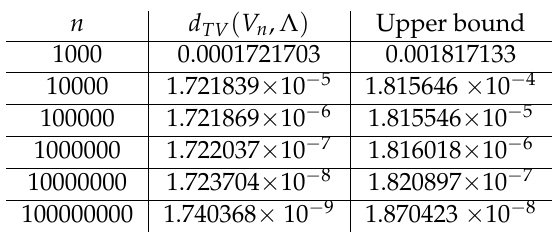
Table 3. Numerical results for a = c = 1